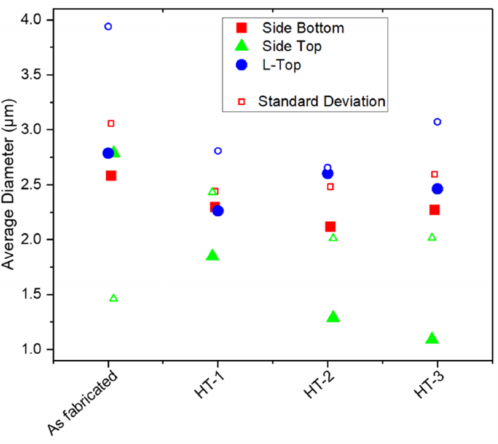
Figure 4. Mean diameter of three center areas for as-fabricated and heat-treated conditions. Full symbols represent the mean diameter, while corresponding open symbols represent the standard